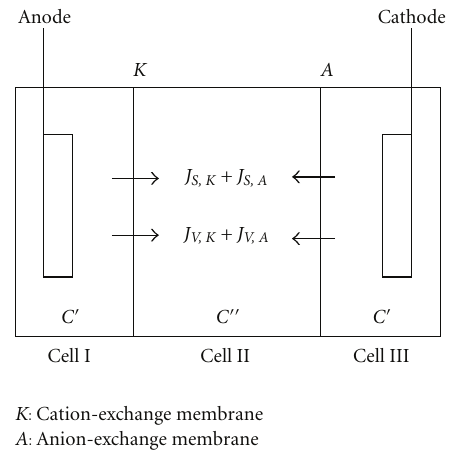
Figure 1: Three-cell electrodialysis